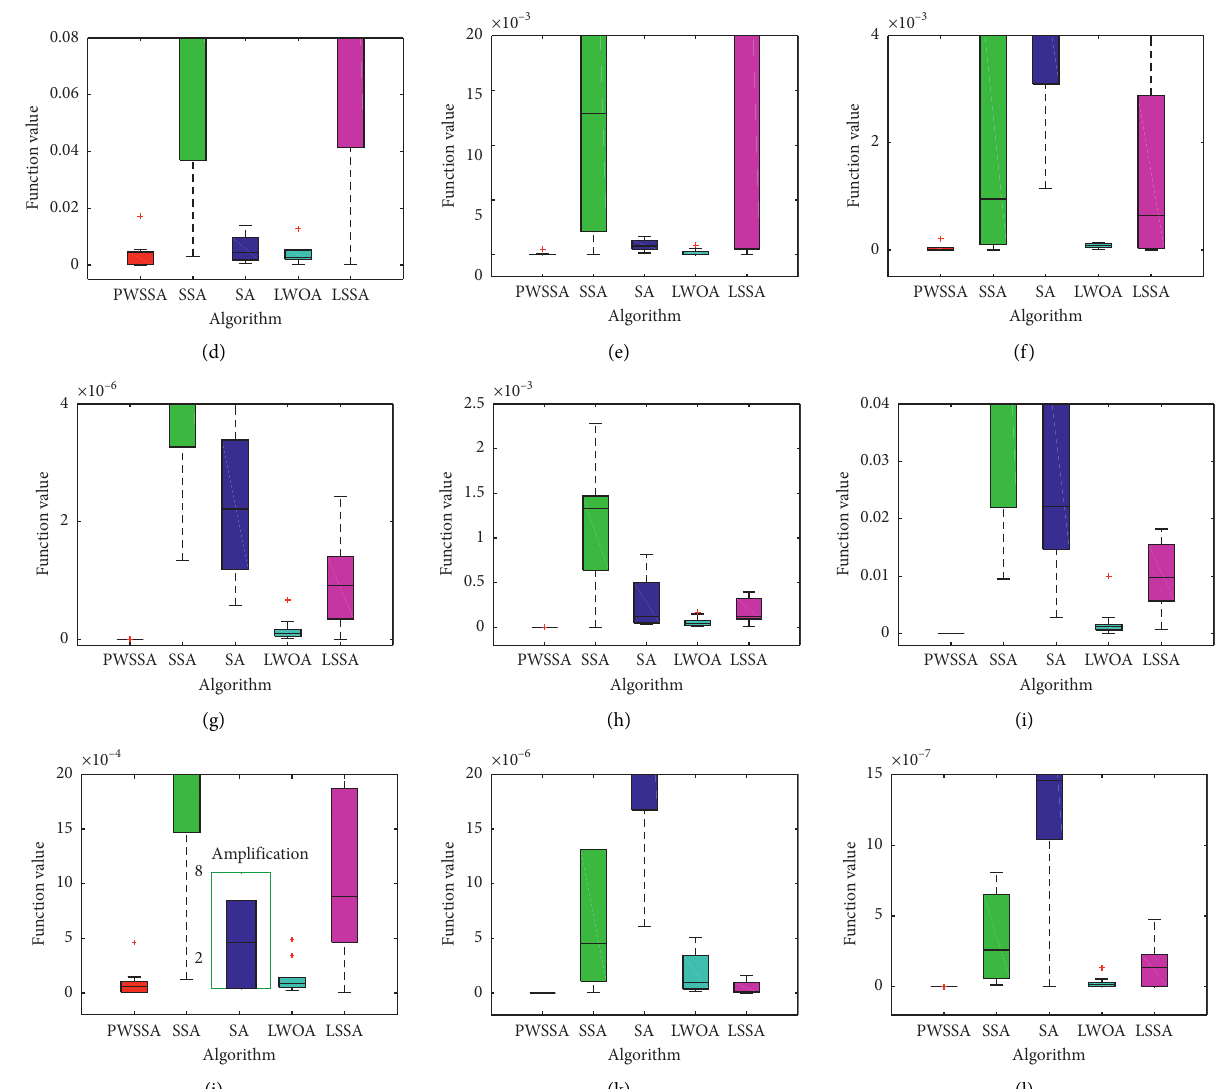
Figure 4: Box-plot charts of functions ( D � 2). (a) f 1 . (b) f 2 . (c) f 3 . (d) f 4 . (e) f 5 . (f) f 6 . (g) f 7 . (h) f 8 . (i) f 9( D � 2) . (j) f 10( D � 2) . (k) f 11( D � 2) . (l) f 12( D � 2)